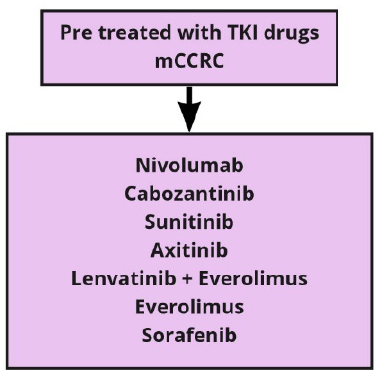
Figure 2. Second line therapy in metastatic clear cells renal carcinoma (mCCRC).